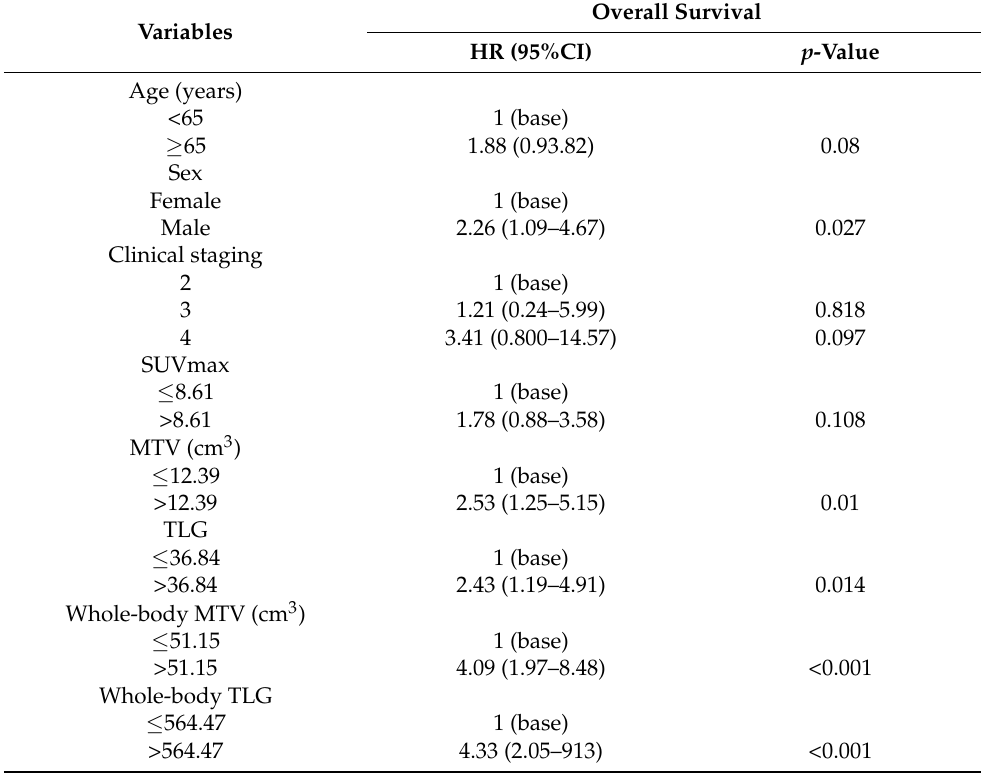
Table 3. Univariate analysis of demographic and clinicopathology in relation to overall survival.